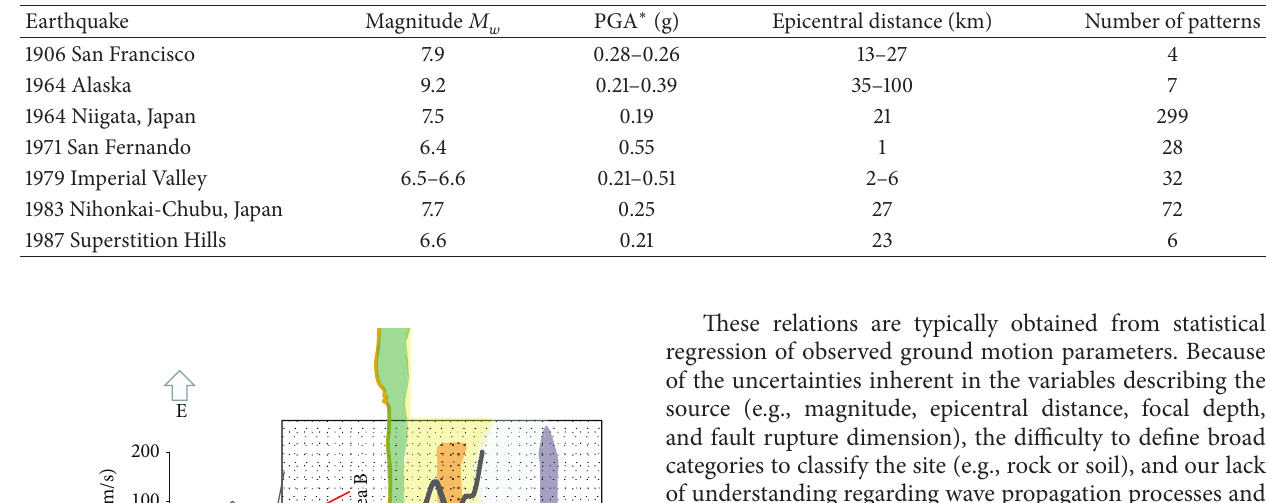
Table 3: Seismic events contained in the database.